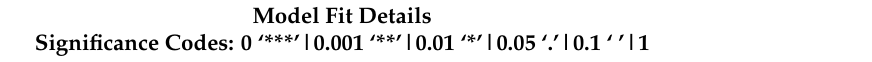
Table 2. Fitted segmented model details (minimal base model (level)).